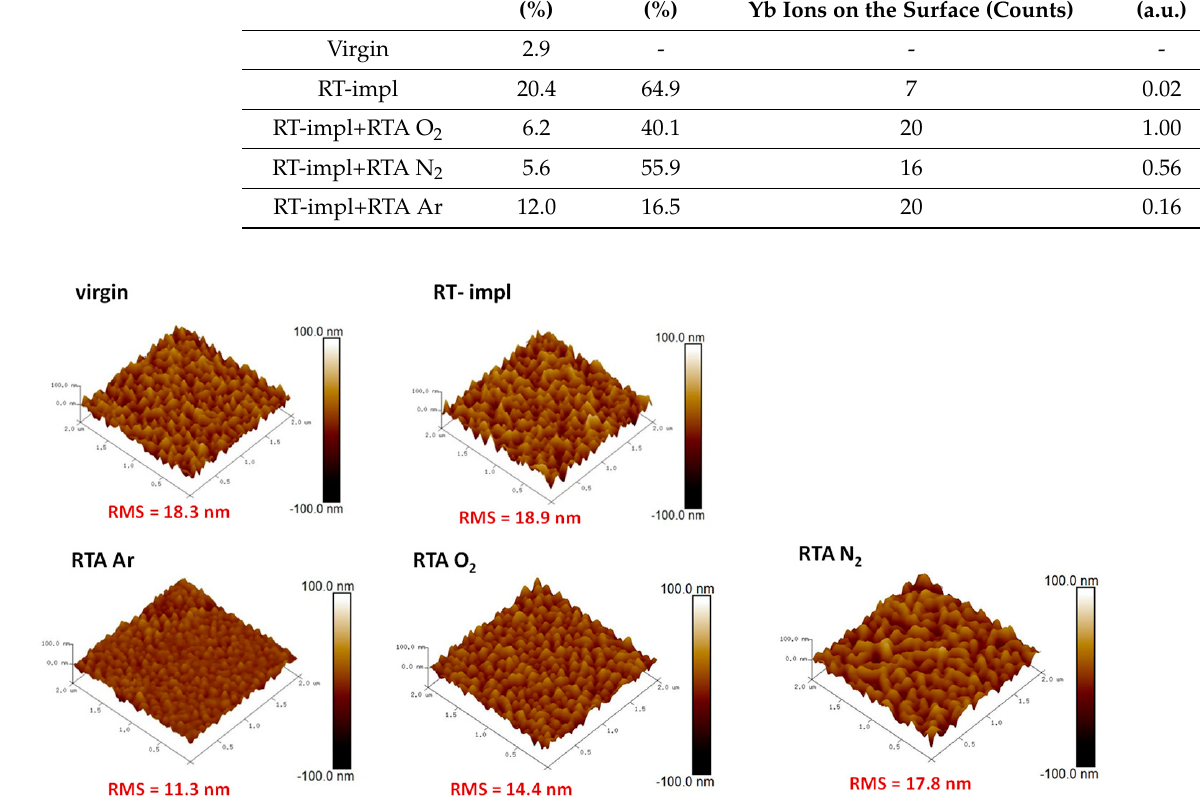
Figure 7. AFM imaging of the surface morphology for ZnO implanted with 150 keV Yb ions to the